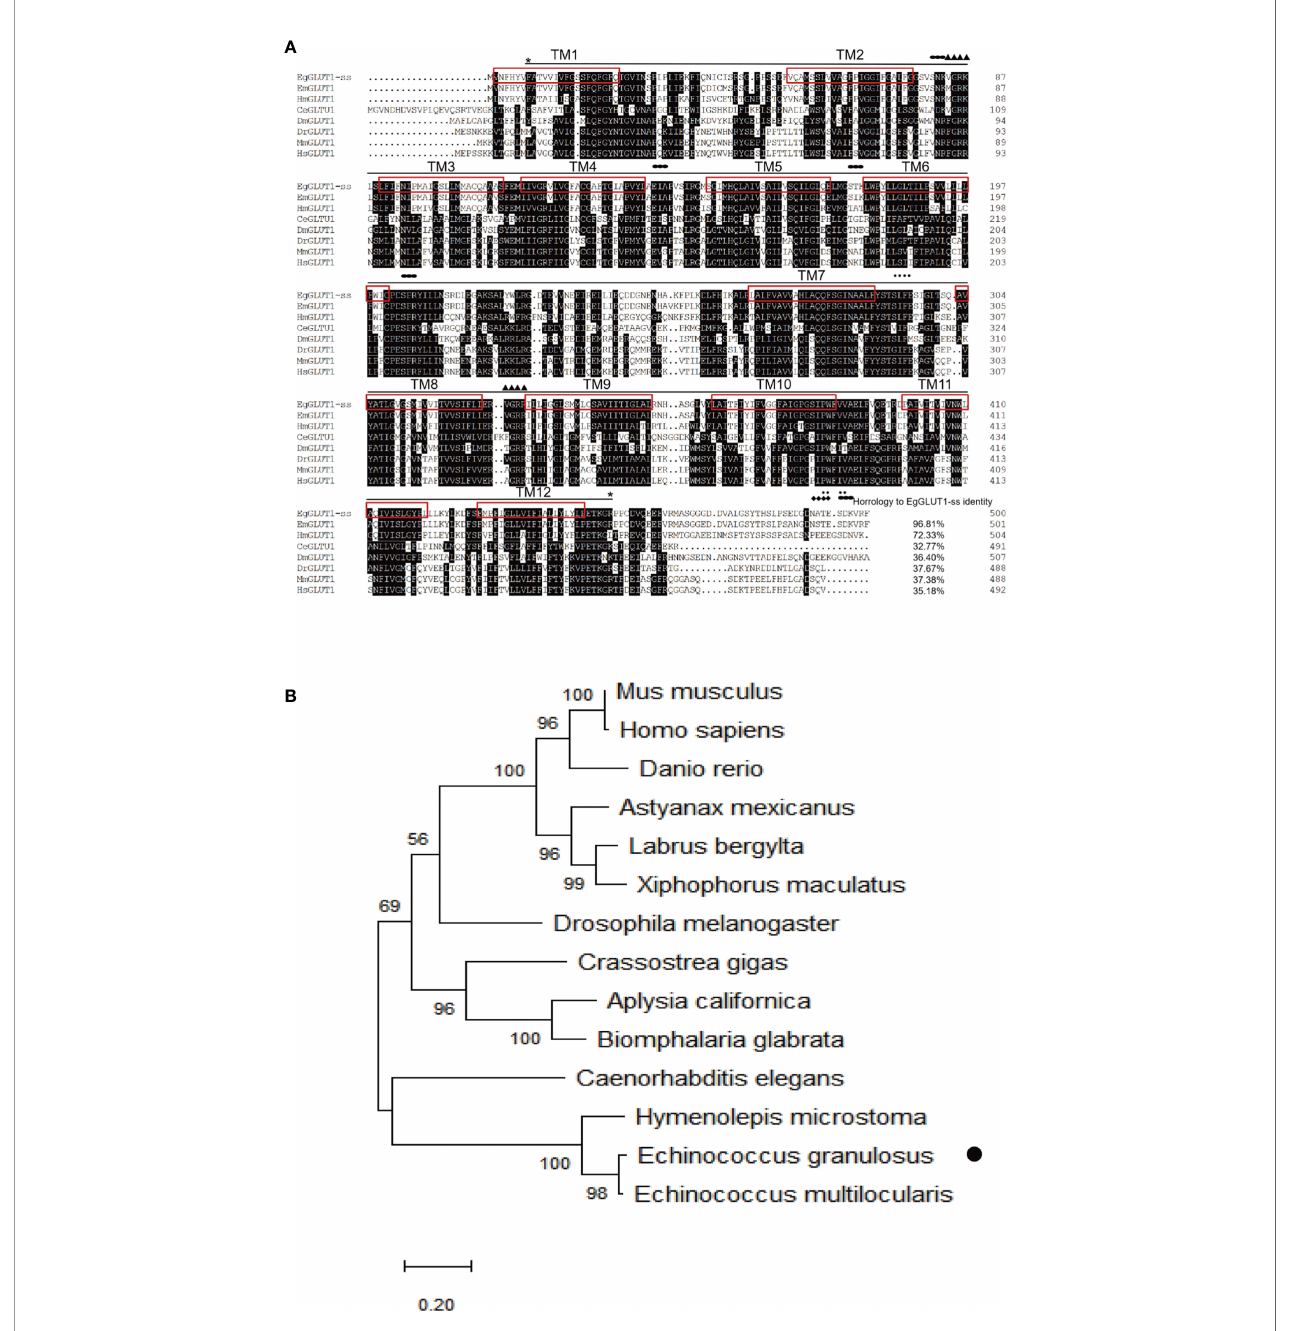
FIGURE 1 | EgGLUT1-ss bioinformatics analysis. (A) Multiple-sequence alignments of EgGLUT1-ss from E granulosus s.s. (GenBank accession number: QTT61014.1); Echinococcus multilocularis (GenBank accession number CDS42031.1); Hymenolepis microstoma (GenBank accession number CDS25463.1); Caenorhabditis elegans (GenBank accession number NP_493981.1); Drosophila melanogaster (GenBank accession number NP_001097467.1); Danio rerio (GenBank accession number NP_001034897.1); Mus musculus (GenBank accession number XP_006502971.1); and Homo sapiens (GenBank accession number NP_006507.2). The horizontal line between the two * represents the MFS super family; ( ▲ ) denotes the amidation site; ( ◆ ) denotes the glycosylation site; (·) denotes Casein kinase II phosphorylation site; ( ● ) denotes protein kinase C phosphorylation site. The red box represents the transmembrane (TM) region. (B) Phylogenetic tree constructed using the neighbor-joining method to compare the relationship between EgGLUT1-ss and GLUT1 from other species. The numbers above the branches refer to bootstrap values. The species for sequences included in the phylogenetic analysis are shown behind the branches. EgGLUT1-ss from E granulosus s.s. is indicated by (cid:129)